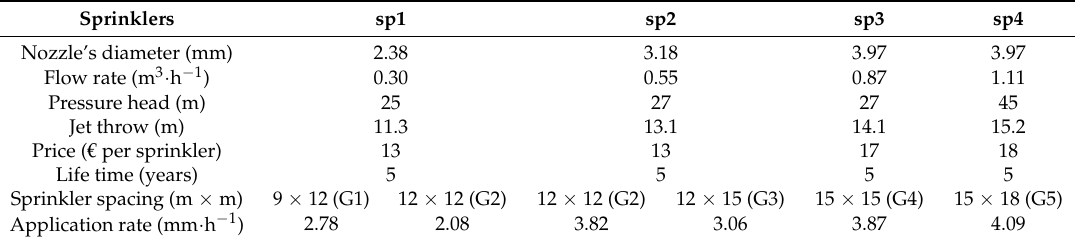
Table 2. Wheat irrigation scheduling for surface and sprinkler systems at Ras ‐ El ‐ Ain considering mild (MD) and moderate ‐ deficit (MoD) irrigation.